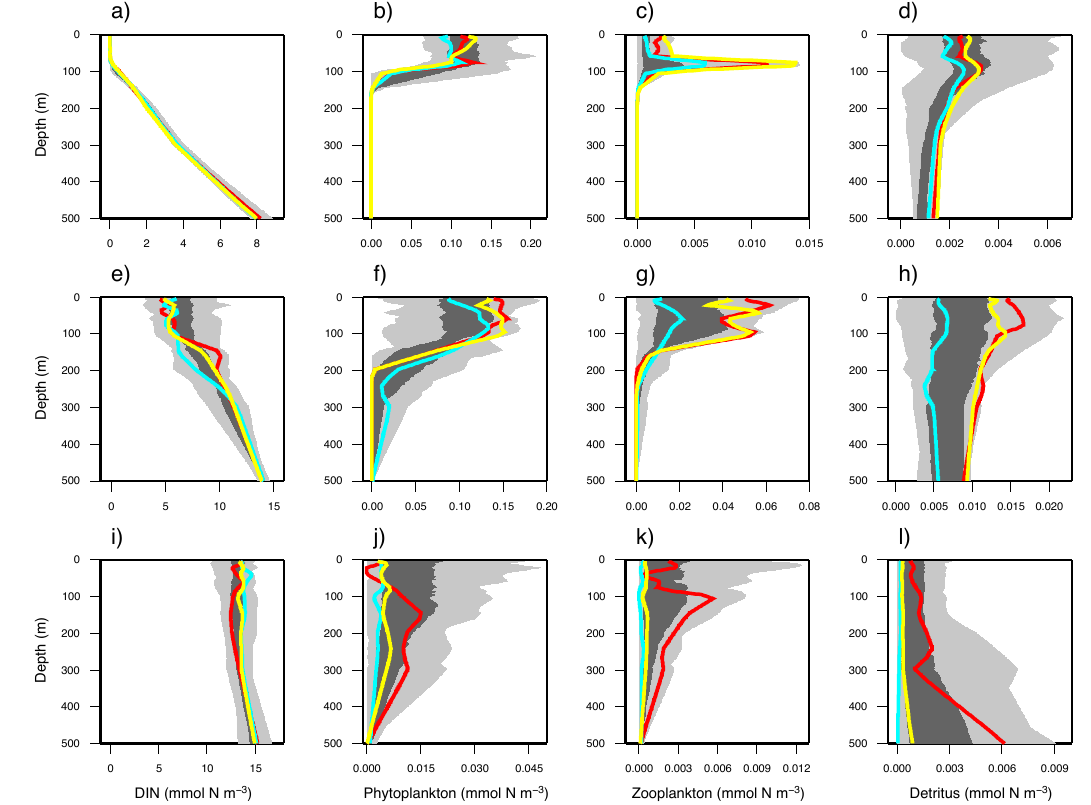
Fig. 5. Illustration of the 100 member initial state ensemble. For the BATS site: (a) DIN ( N ), (b) phytoplankton ( P ), (c) zooplankton ( Z ) and (d) detritus ( D ). (e–h) Same variables at the NABE site. (i–l) Same variables at the OWS-INDIA site. Full ranges (light grey), inter-quartile ranges (dark grey) and three example members (coloured) are shown.